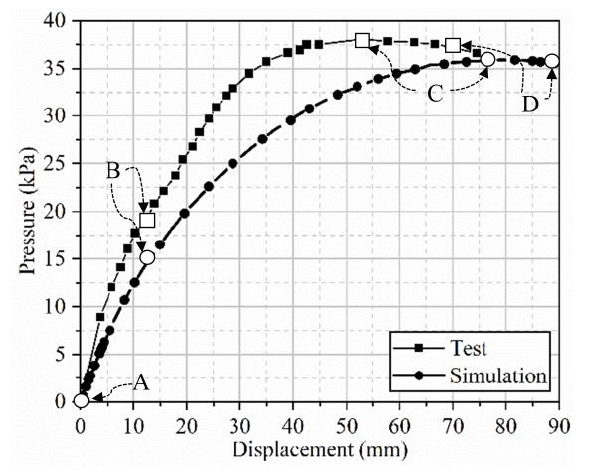
Figure 5. Comparing the pressure – displacement curves of test and simulation divided into float- ing stage (AB), buckling stage (BC) and failure stage